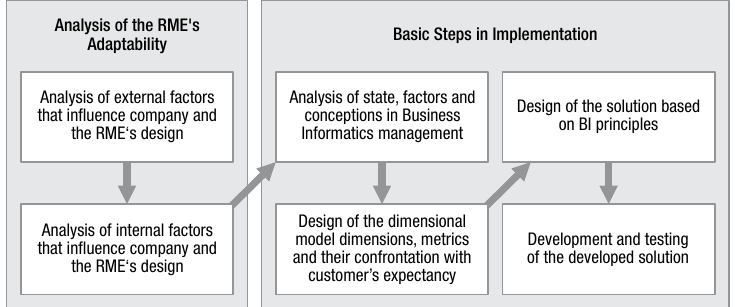
Basic Steps in ImplementationAnalysis of the RME's Adaptability